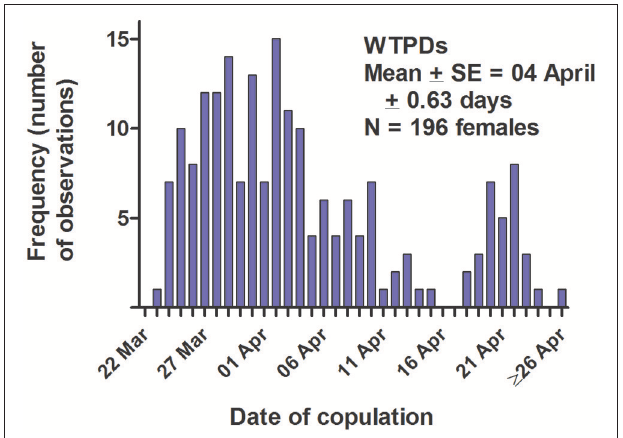
FIGURE 7 | Number of sexual partners per year for male and female white-tailed prairie dogs at the Arapaho National Wildlife Refuge, Colorado USA, from 2006 through 2012. These data are from behavioral observations of copulations involving marked individuals.